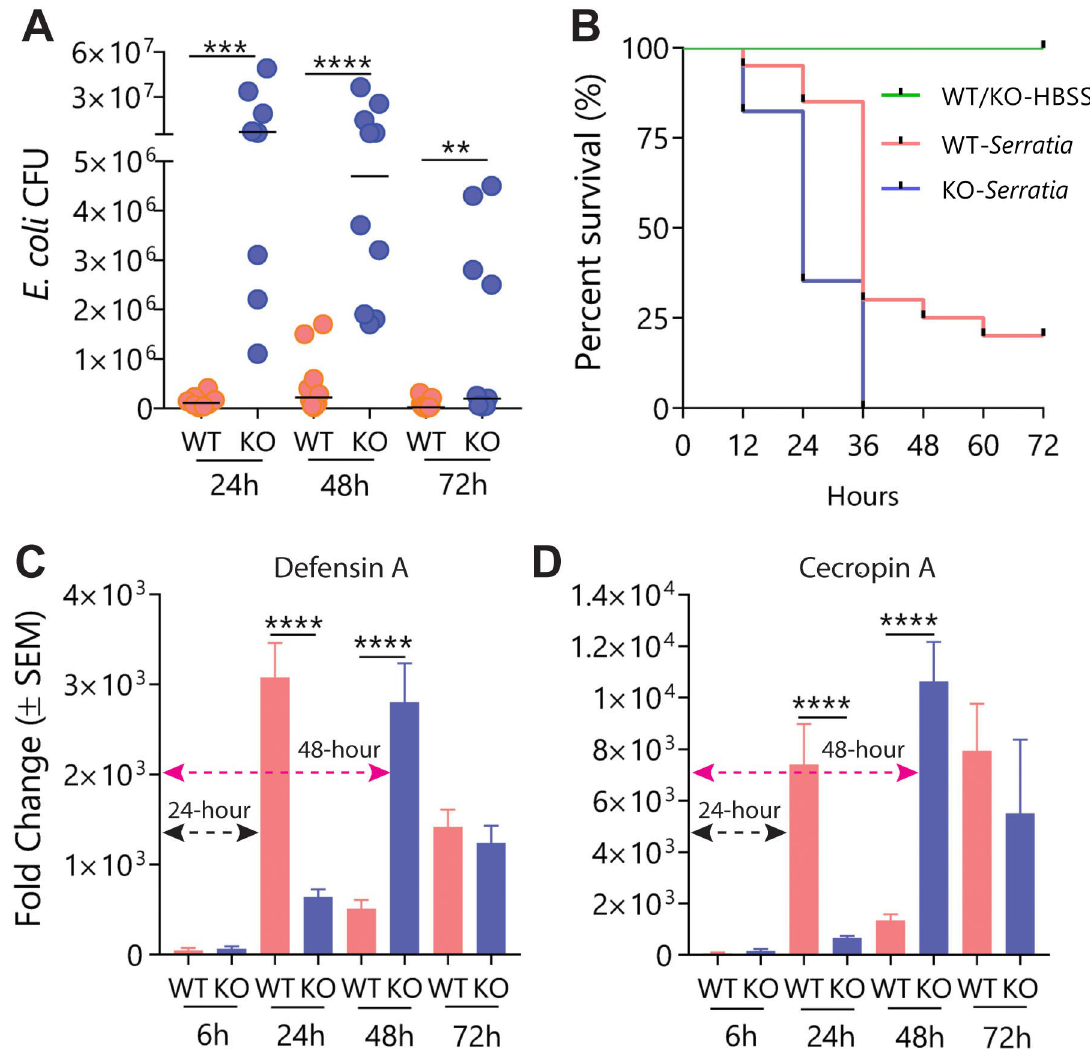
Fig 3. Effect of mJHBP deficiency on innate immune responses after bacterial challenge. A. mJHBP -/- ( KO ) mosquitoes are unable to control bacterial infection. Bacterial counts (CFU) from 3 biological replicates of 2–4 individual WT and KO mosquitoes infected with E . coli (OD 600 = 0.1) 24 (n = 8), 48 (n = 10) and 72 h (n = 11) post-infection. Significance levels (Mann-Whitney U test) are indicated as asterisks ( ���� p � 0.0001, ��� � 0.001, �� � 0.01, � � 0.05). Median values are shown as horizontal lines. Mortality of E . coli -injected mosquitoes was negligible. B. Effect of mJHBP deficiency on the survival of mJHBP -/- ( KO ) mosquitoes. Kaplan-Meier survival curves for WT (n = 20) and KO (n = 17, two biological replicates) females infected by S . marcescens (OD 600 = 0.05) shows that KO mosquitoes succumbed earlier than WT females. The median survival between WT and KO mosquitoes was statistically significant (Log-rank test, p � 0.0001). C,D. Effect of mJHBP deficiency on the expression of the antimicrobial peptides defensin A ( C ) and cecropin A ( D ) in the fat body of E . coli -challenged females measured at 6, 24, 48 and 72 h post-infection (n = 9, 3 biological replicates of 3 individuals). mJHBP -/- ( KO ) mosquitoes exhibited a 24 h delay in the induction of both AMPs. Changes in expression were calculated by comparing the Δ Ct of infected mosquitoes with that of LB-injected mosquitoes (2 - ΔΔ Ct). Black arrow: time of induction to maximum expression level in the WT strain = 24 h; Magenta arrow: time of induction to maximum expression in the KO strain = 48 h. Data were analyzed using the Mann-Whitney U test ( ���� p � 0.0001). Again, mortality of E . coli -infected mosquitoes was negligible. mosquitoes in response to bacterial injection. Expression levels of defensin A , cecropin A , atta- cin B and gambicin were far lower in the midgut than the fat body suggesting that bacteria introduced by thoracic injection do not induce expression in midgut tissue as efficiently as in the fat body (Fig 4E–4H). The levels of AMP expression in midguts also did not differ